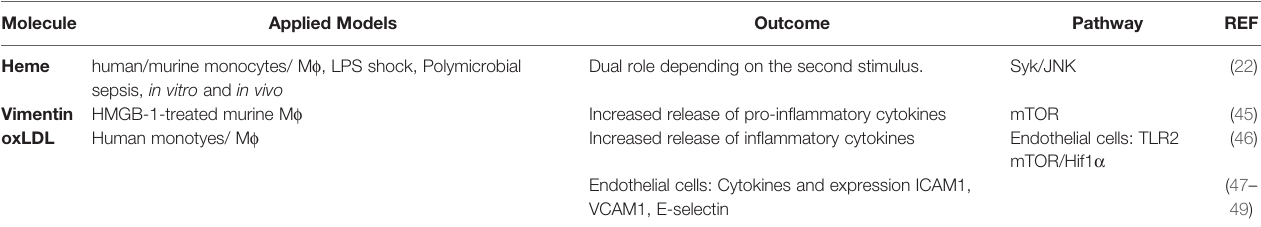
TABLE 2 | DAMPs for which innate immune training has been shown. Molecule